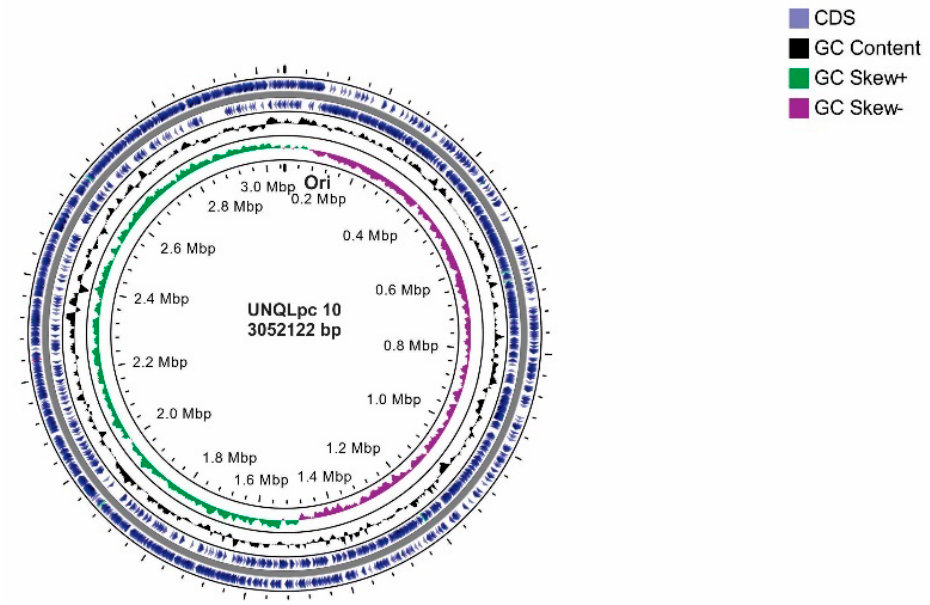
Figure 1. Chromosome atlas of the Lacticaseibacillus paracasei UNQLpc 10 strain generated using CGView v1.0 (Grant & Stothard, 2008). The GC content is illustrated in the black circle; the positive and negative GC skew is illustrated in the green and purple circles, respectively; and the CDS (Co Ding Sequence) is illustrated in the blue circle. Genome positions in kbp are also shown.